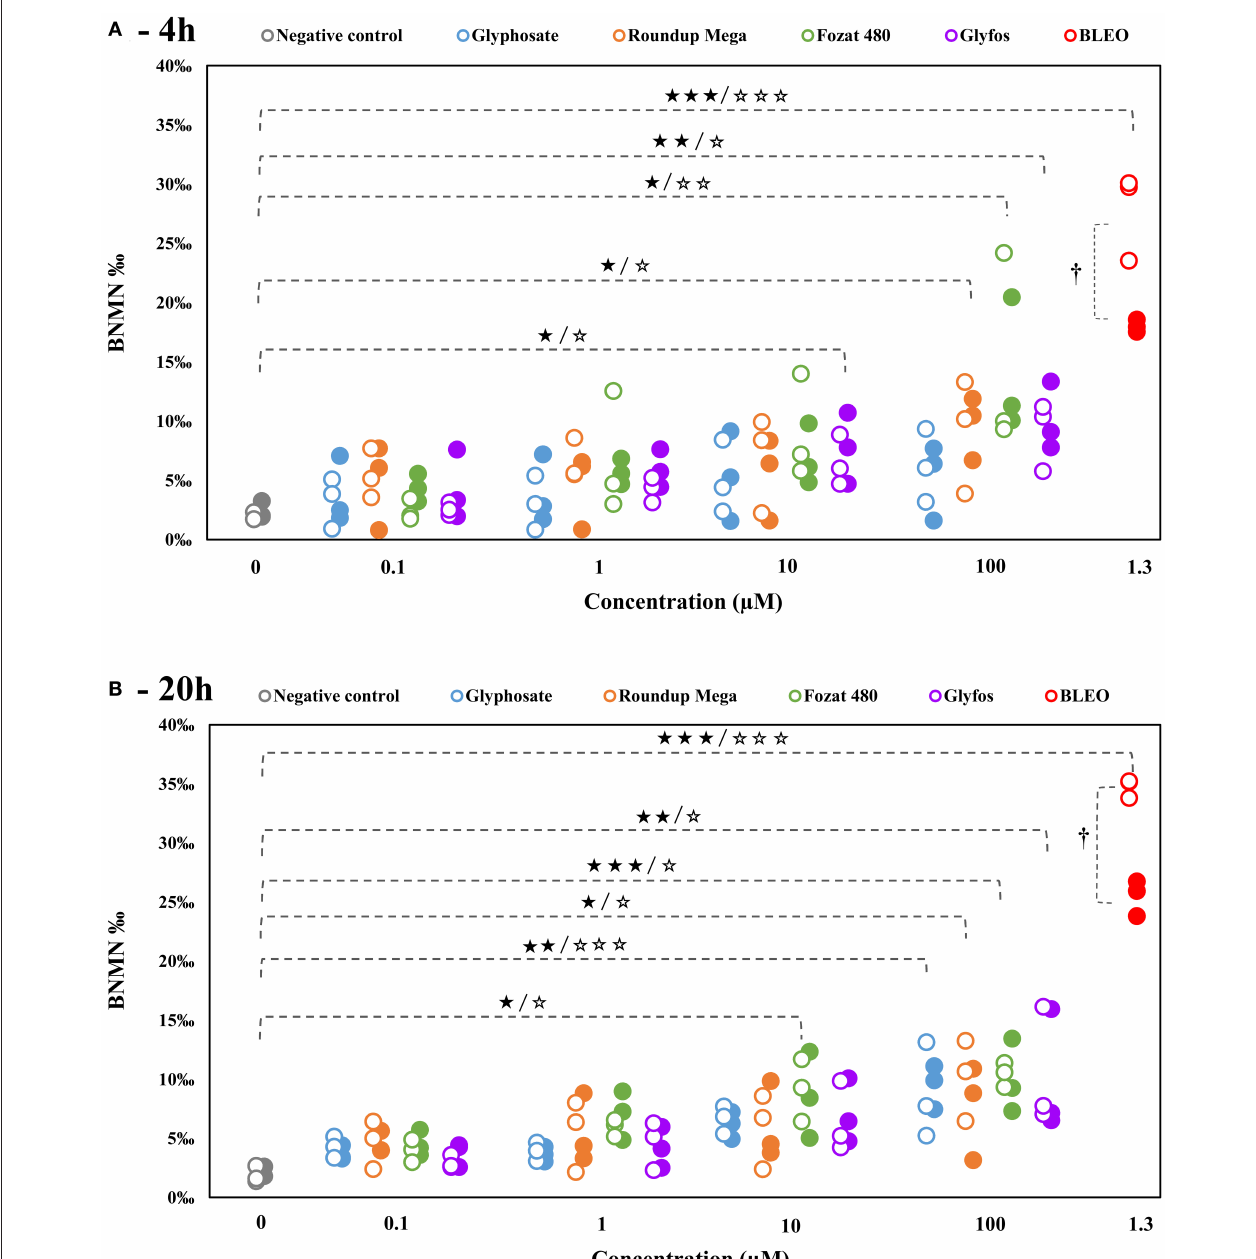
FIGURE 3 | Frequency of binucleated cells with micronuclei (BNMN %) induced by 4-h (A) and 20-h (B) exposure to sub-cytotoxic concentrations of glyphosate and GBHs without ( ◦ ) and with (•) metabolic activation (S9) in human mononuclear white blood cells, detected by cytokinesis-block micronucleus assay. Data points are results of individual experiments. Statistically significant (* p < 0.05, ** p < 0.01, *** p < 0.001) increase was determined by comparing the frequency of binucleated cells with micronuclei induced by various doses of test chemicals to the background level of untreated cells by ANOVA with Dunnett’s post hoc test. The same test was used to detect statistically significant ( † p < 0.05) difference in the frequency of binucleated cells with micronuclei between S9-treated and S9-untreated cells induced by the same concentration of test chemicals.